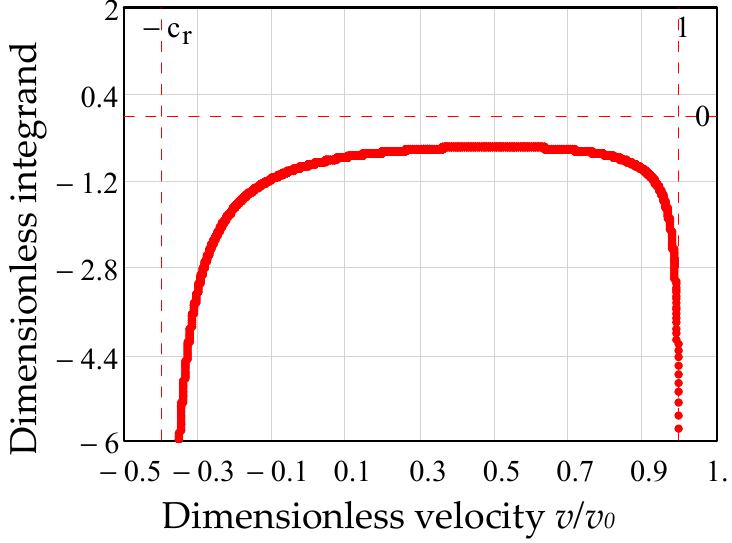
Figure 7. Asymptotes of integrand from Equation (55).